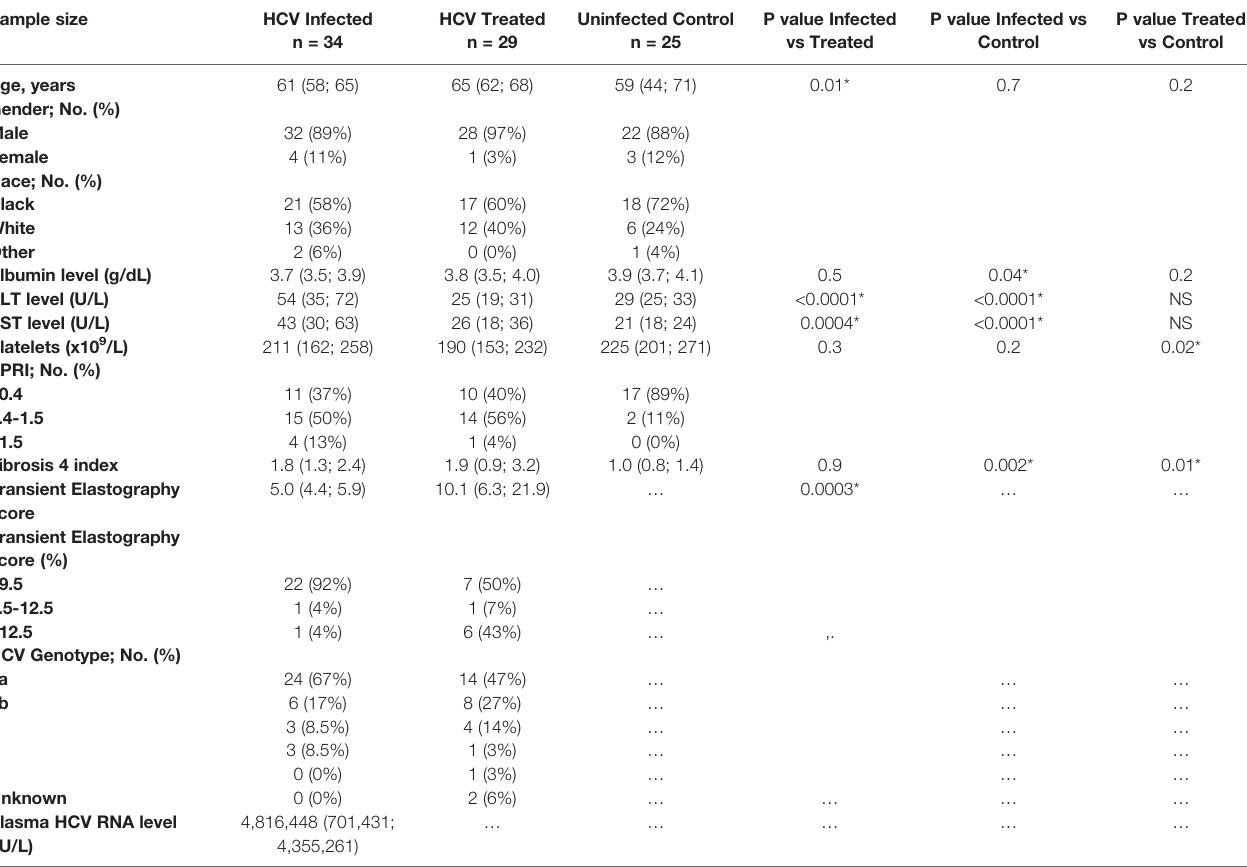
TABLE 1 | Clinical characteristics of cross-sectional